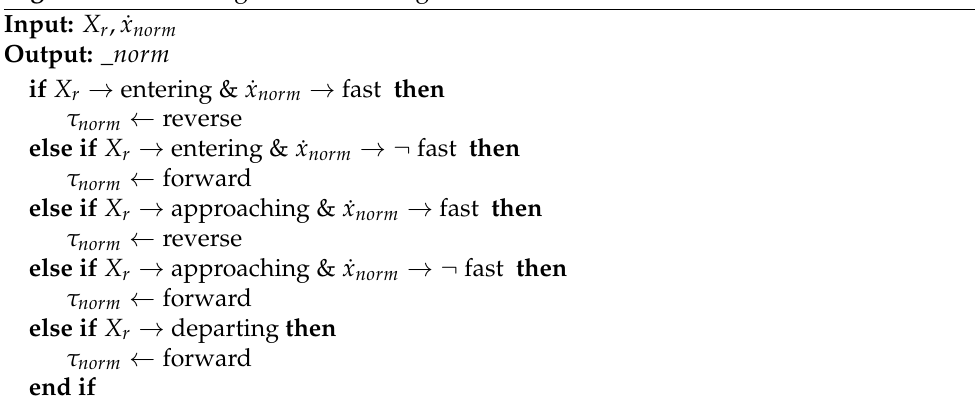
Figure 4. Green light fuzzy sets. Algorithm 2 Green light FIS knowledge